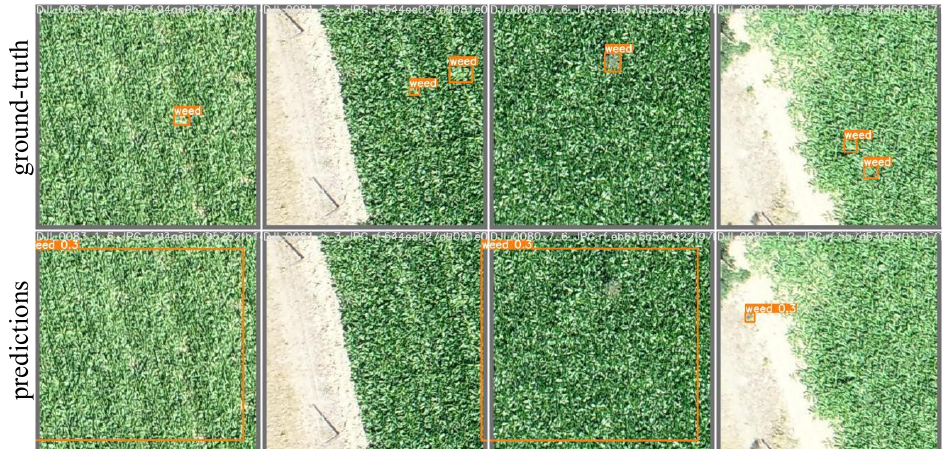
Figure 4. Three images from the CP test set with bounding boxes predicted by a model pretrained on the LB data set.